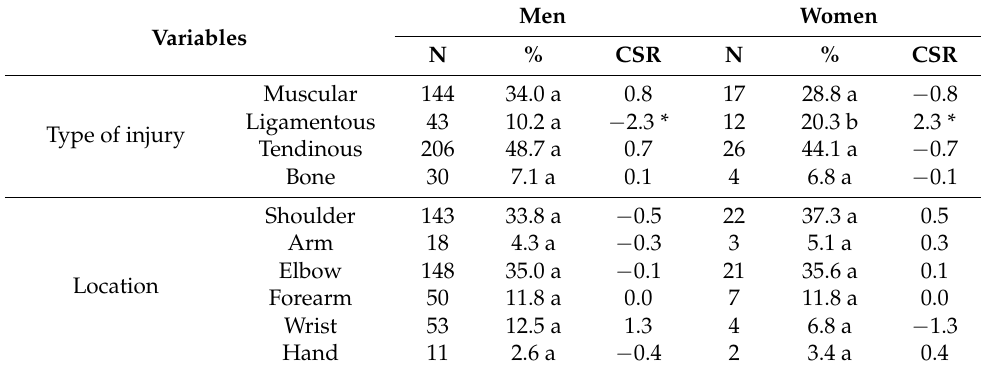
Table 4. Differences in the characteristics of upper limb injuries between men’s and women’s amateur padel players.